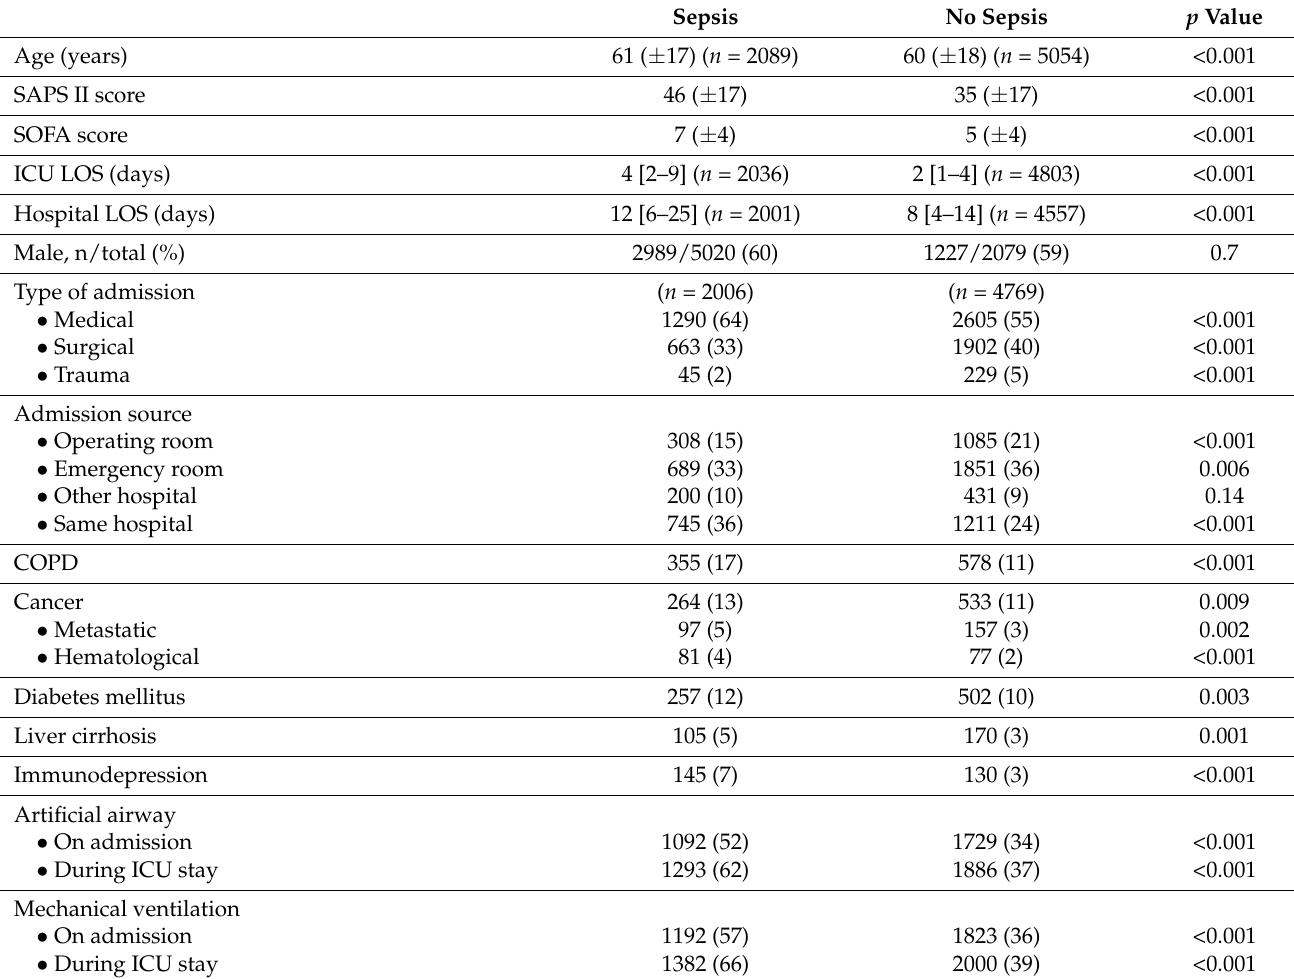
Table 2. Demographics, organ failure, and mortality rate in patients with and without sepsis. Sepsis No Sepsis p